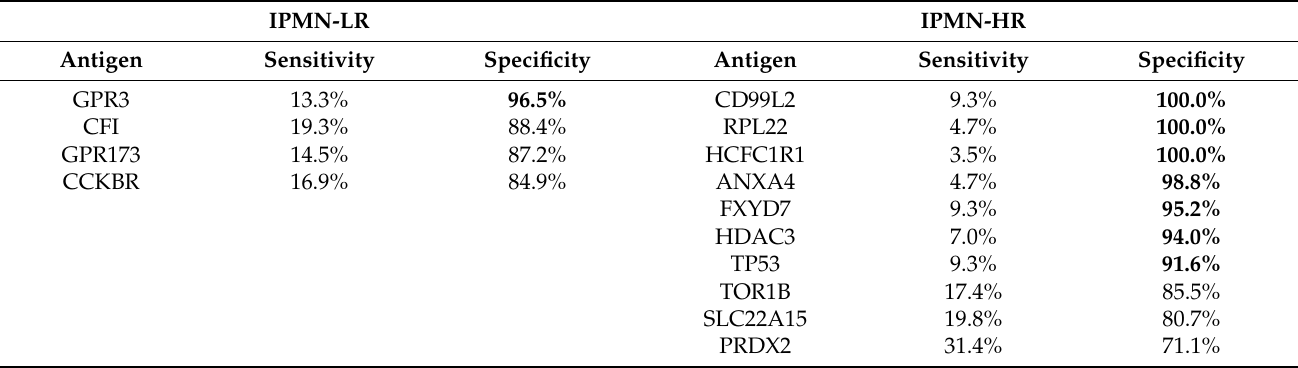
Table 2. Calculation of specificity and sensitivity for the 14 marker antigens for making a distinction between IPMN-LR and IPMN-HR. On the left, markers with high specificity for IPMN-LR. On the right, markers with high specificity for IPMN-HR are listed. Specificity values above 90% are highlighted in bold